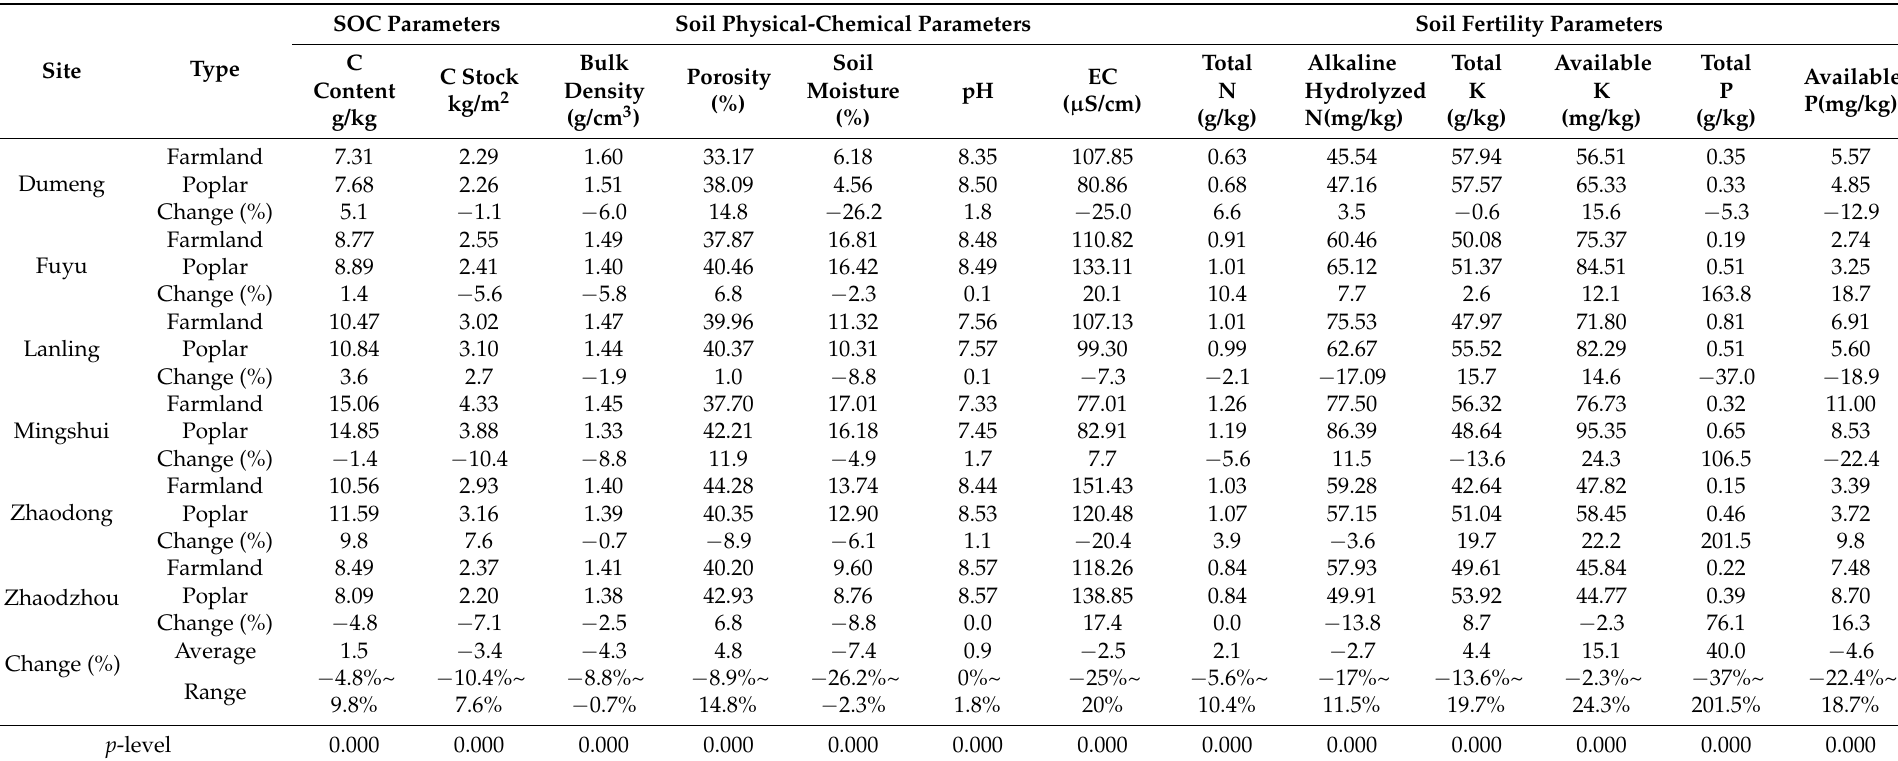
Table 3. Shelterbelt construction and sampling sites significantly affected 13 soil parameters (marked type*site interaction, p < 0.05) and the magnitudes and pattern of the influences. The non-significant factors ( p > 0.05) were not listed